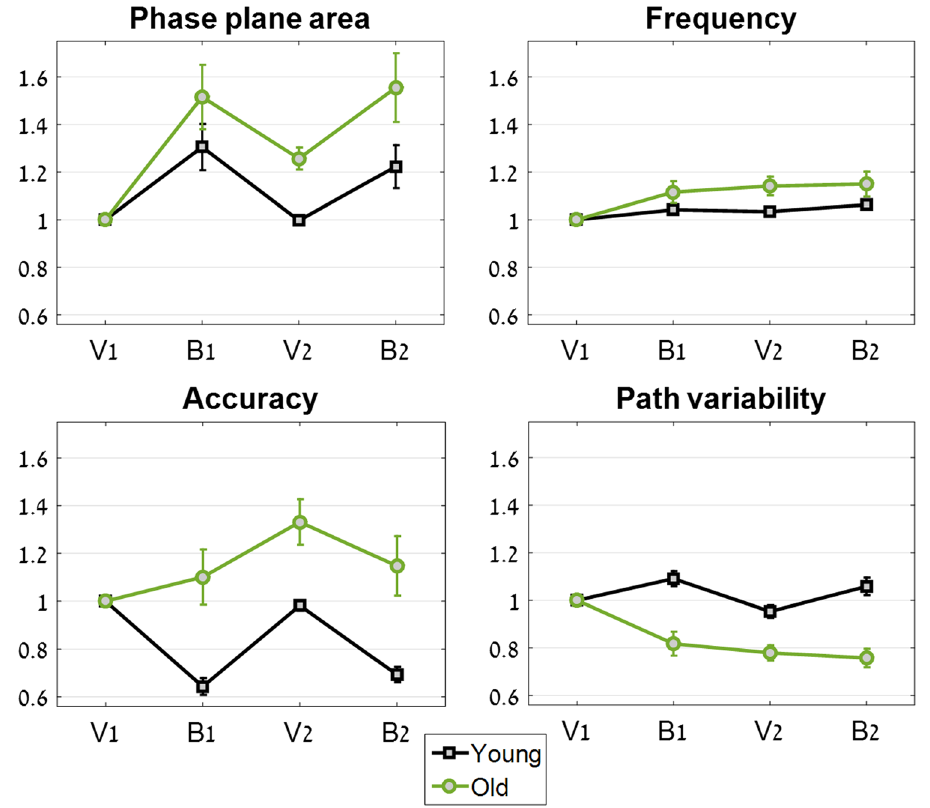
Figure 3. Performance by age groups across the four trial segments. For clarity, all segment values are normalized by the first segment of the trial (V1). The results of the young group are marked in black, and those of the older group are marked in green. Error bars represent standard error. ( A ) Normalized phase-plane area values; ( B ) normalized frequency values; ( C ) normalized accuracy scores; ( D ) normalized path